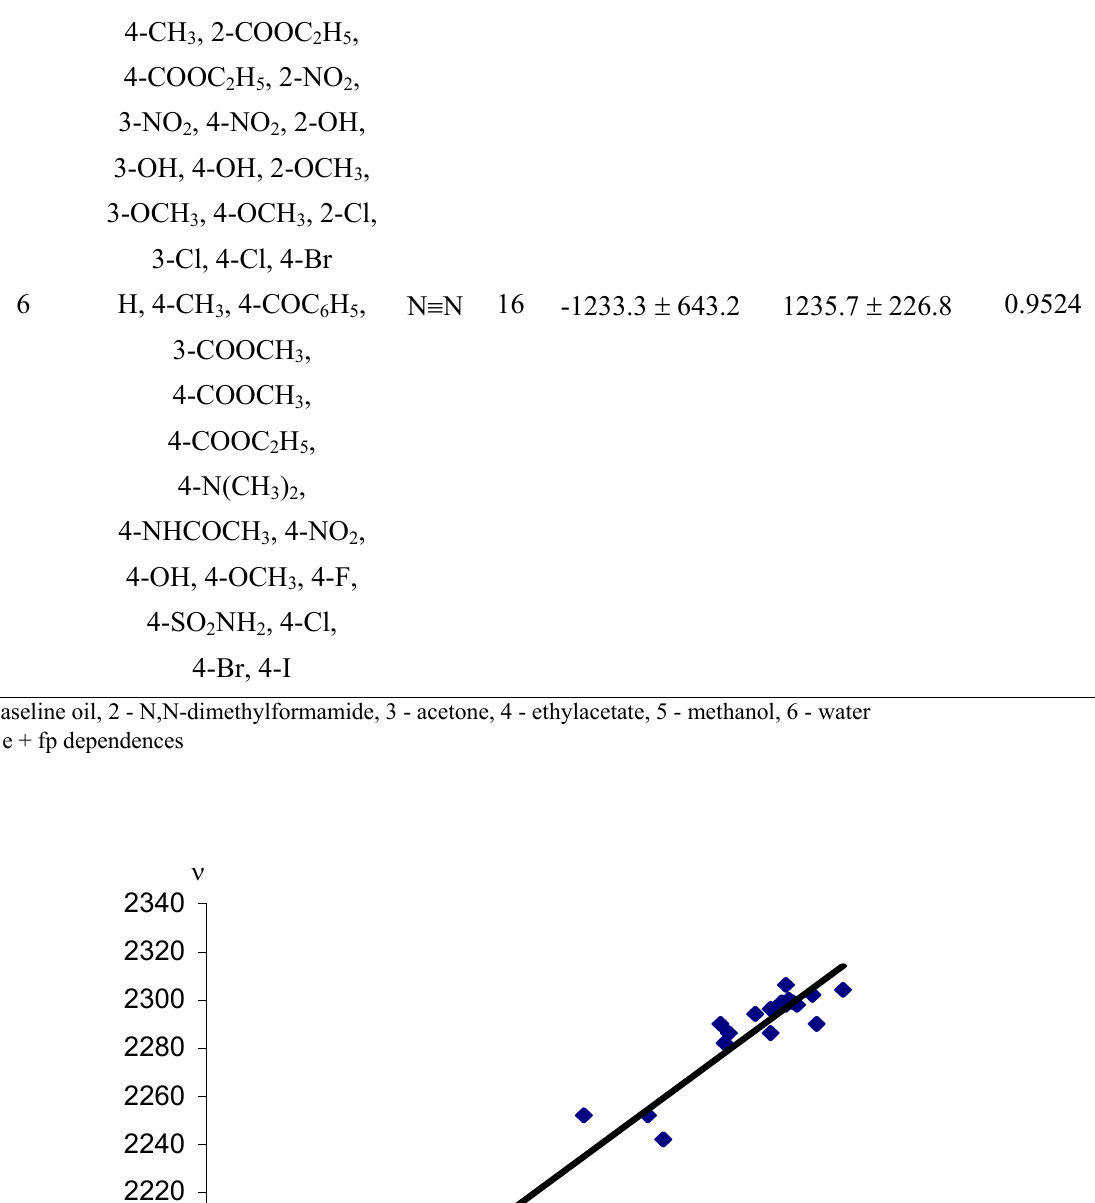
H N + ≡ N cations upon computed N ≡ N bond orders (p). X = H, 6 4 , 3-COOCH , 4-COOCH 3 3 , 4-OCH , 4-F, 4-SO 3 3